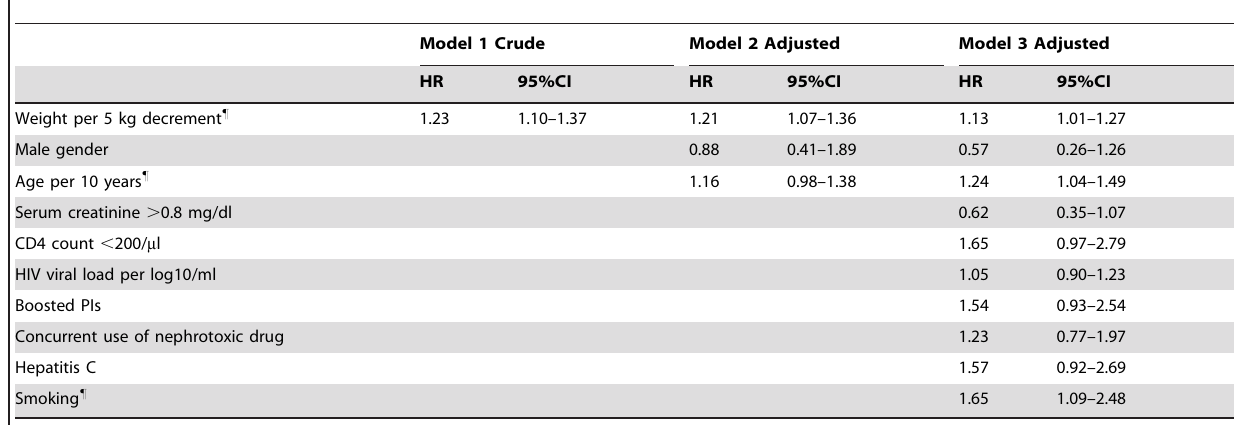
Table 3. Multivariate analysis to estimate the effect of lower body weight on TDF-associated renal dysfunction.